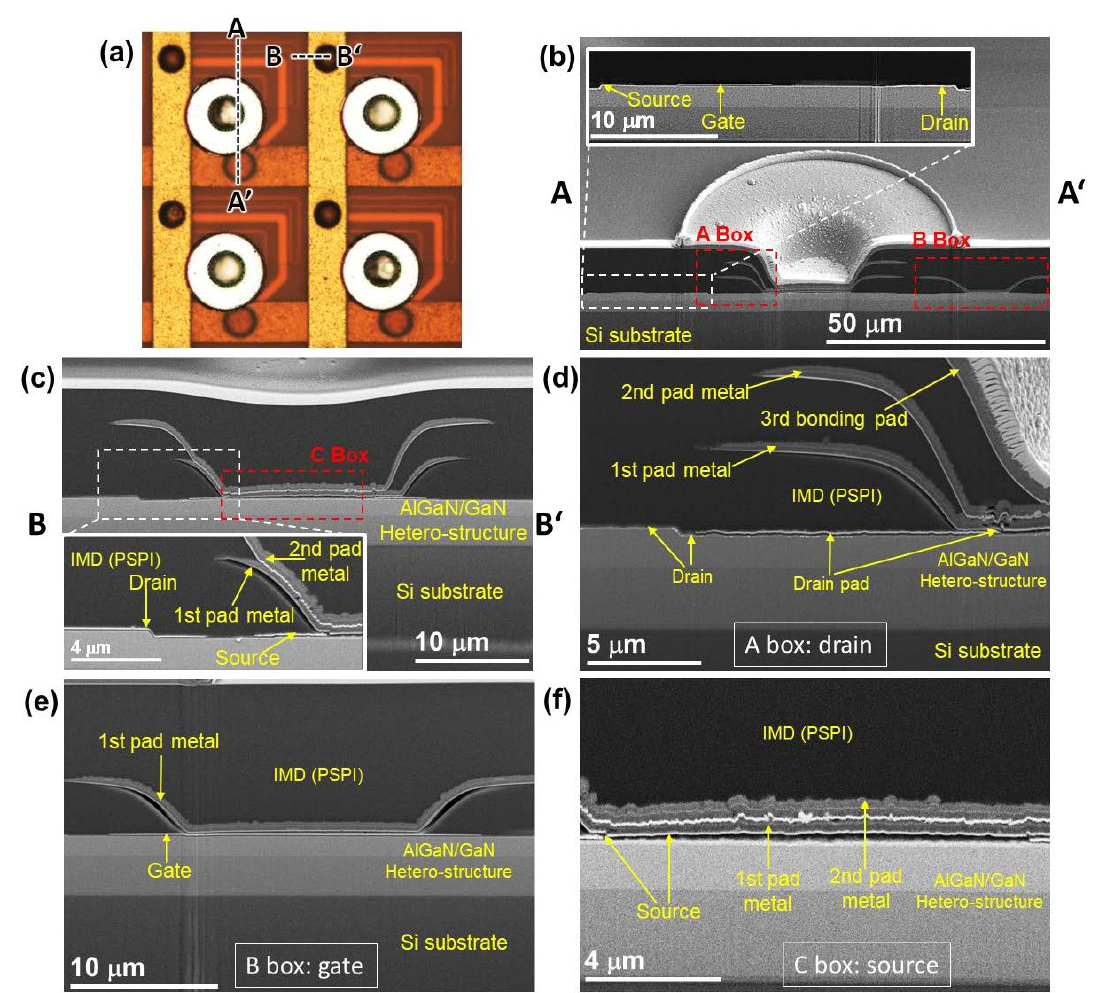
Figure 2. ( a ) Top-view optical microscope image of high-power HEMT arrays. High-resolution FE-SEM cross-sectional images of fabricated HEMT in the ( b ) AA’ and ( c ) BB’ directions according to the optical microscope image. Magnified FE-SEM cross-sectional images of the ( d ) drain, ( e ) gate, and ( f ) source metal pads, as marked by the boxes in ( b , c ), respectively.